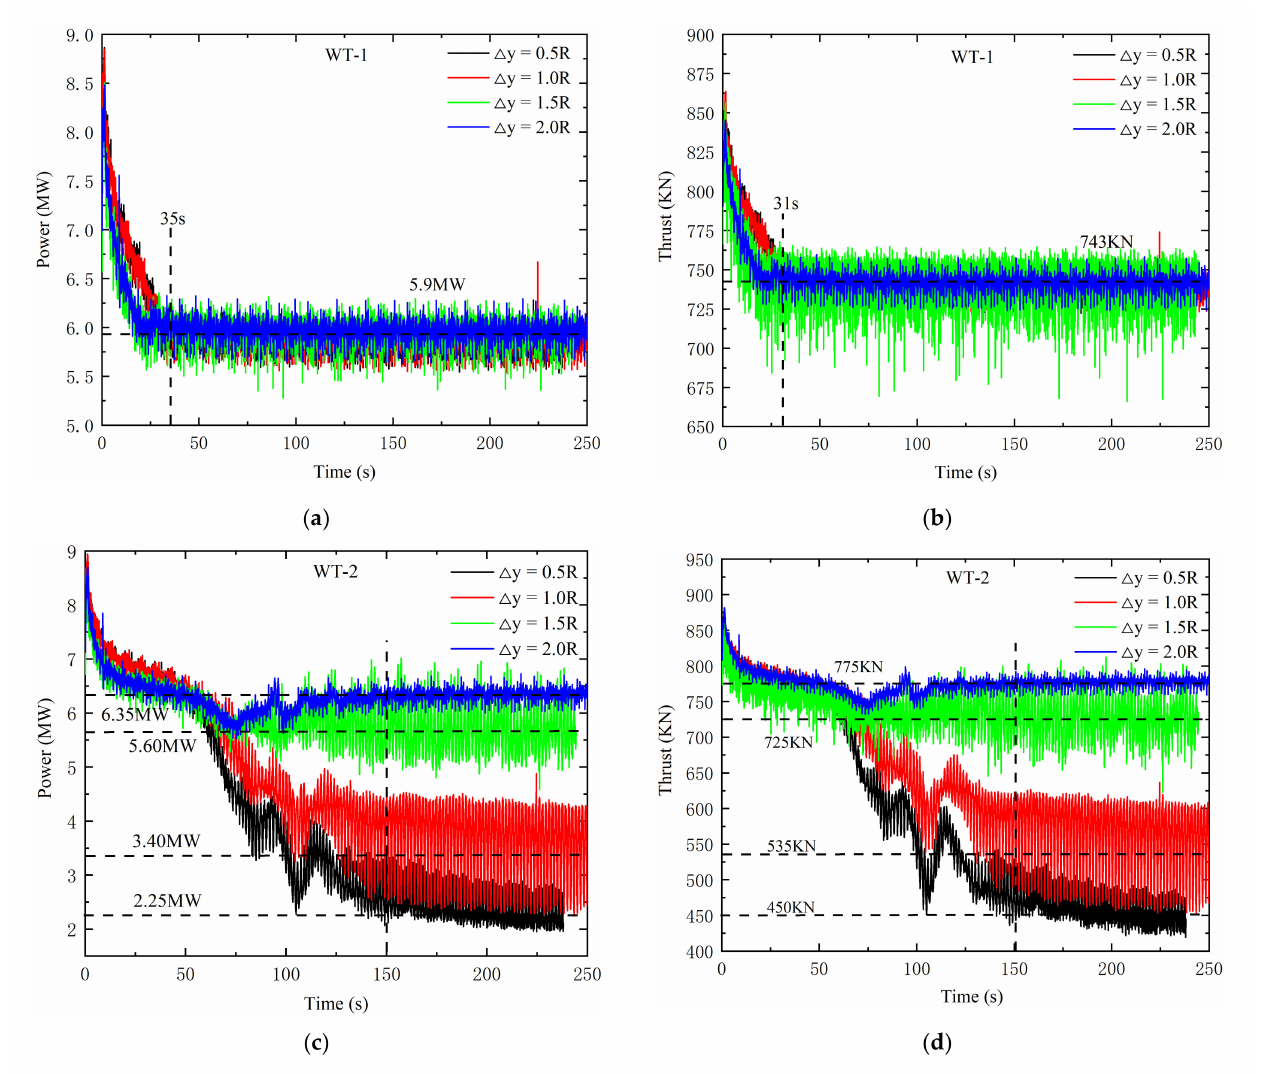
Figure 7. Aerodynamic output power and turbine thrust during simulation time. ( a ) Output power of WT-1 (the standard deviations are 0.08, 0.08, 0.12, and 0.08, respectively); ( b ) Thrust of WT-1 (the standard deviations are 4.37, 4.29, 12.82, and 4.15, respectively); ( c ) Output power of WT-2 (the standard deviations are 0.29, 0.66, 0.45, and 0.08, respectively); ( d ) Thrust of WT-2 (the standard deviations are 31.74, 46.85, 28.13, and 5.29,